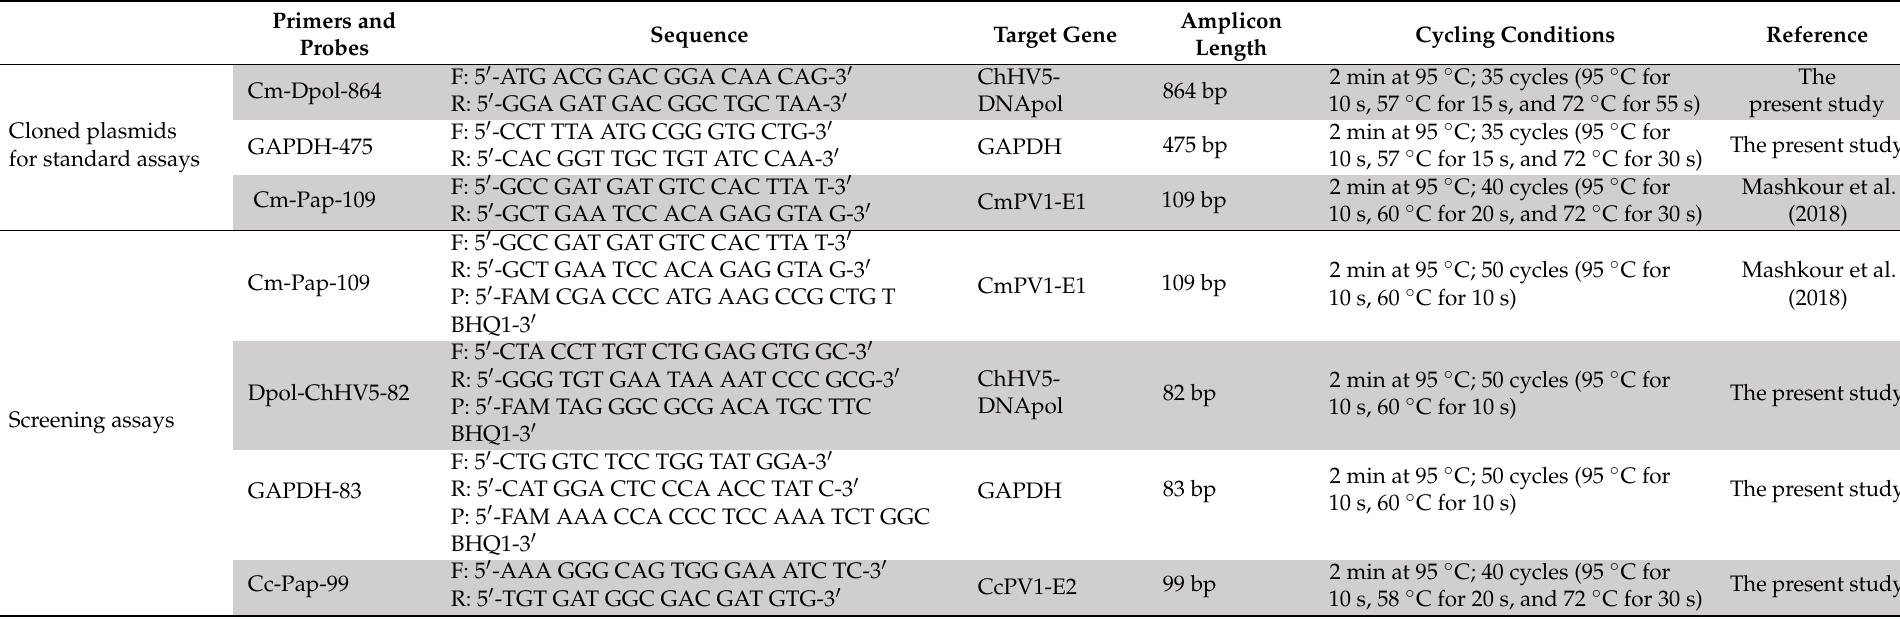
Table 2. The sequences of the PCR primers and probes along with the PCR cycling protocols used in the PCR to amplify the target genes from cloned plasmids (standards),